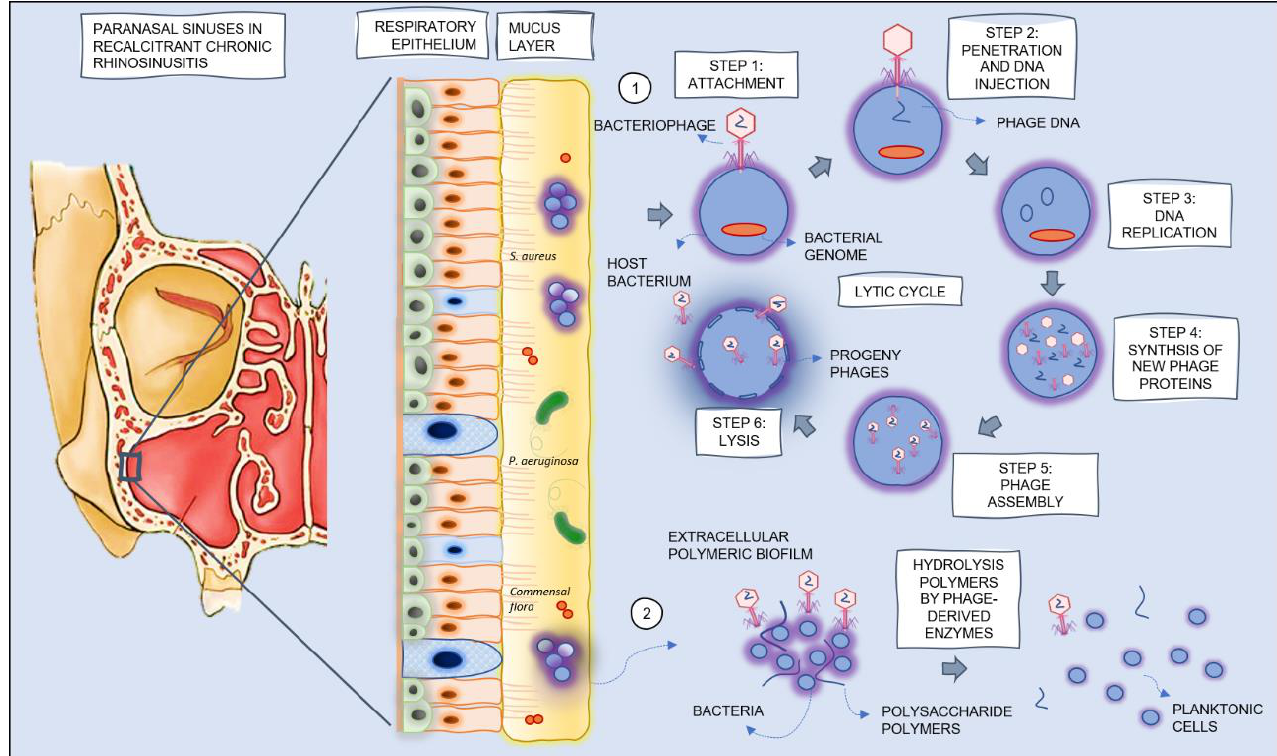
Figure 1. Schematic overview of part of the pathophysiology of recalcitrant CRS with biofilm formation, dysbiosis, overgrowth of S. aureus or P. aeruginosa and the theoretical mechanisms of action of bacteriophages in the treatment of recalcitrant CRS: (1) lysis of bacteria during the lytic phase of bacteriophage replication and (2) reduction of biofilm mass by hydrolysis of polymers by phage-derived enzymes.